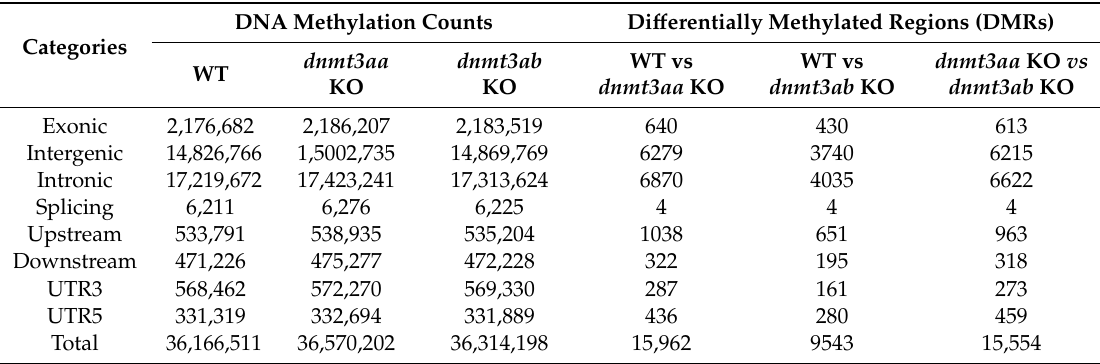
Table 3. DNA methylation counts and di ff erentially methylated regions (DMR) in zebrafish with di ff erent genetic backgrounds for either wild type (WT), dnmt3aa KO, or dnmt3ab KO